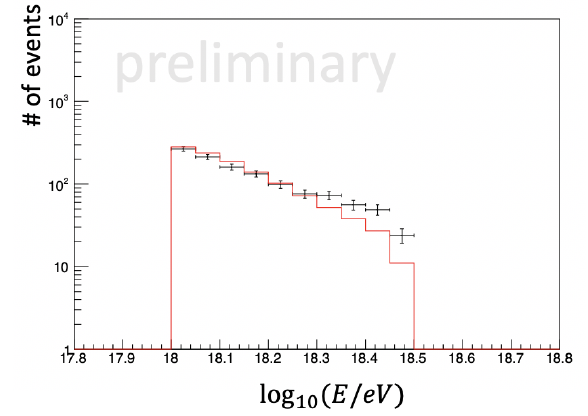
Figure 3. Residual intensities vs right ascension from two-years of TALE SD data (black points). The red curve shows a fitted result by r α cos( α + ϕ α )